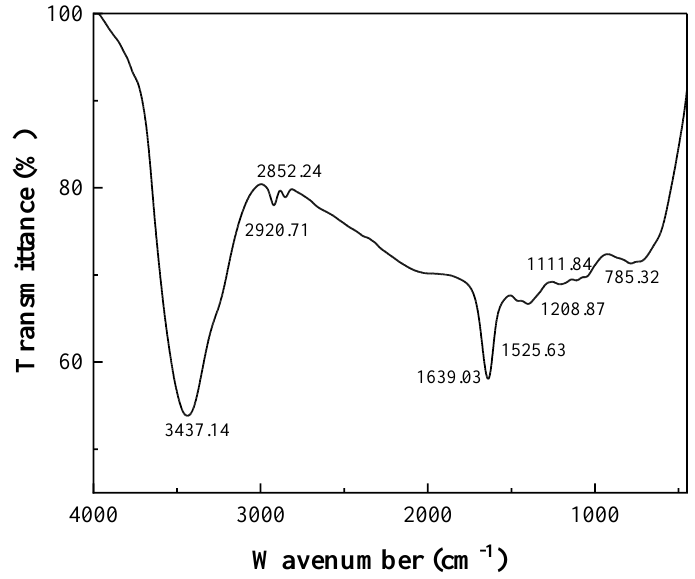
Figure 2. Fourier Transform Infrared (FTIR) Spectroscopy of CQD-W.